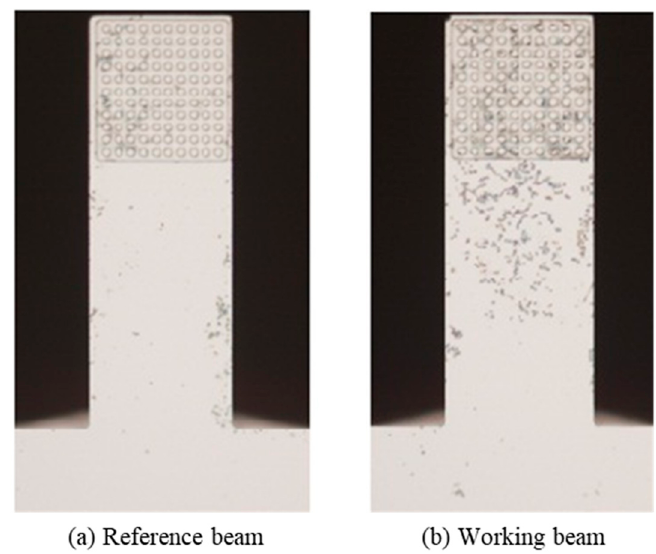
Figure 9. Detection results of Yesinia with microfluidic platform at a flow rate of 1 mL / min: ( a ) reference beam and ( b ) working beam.